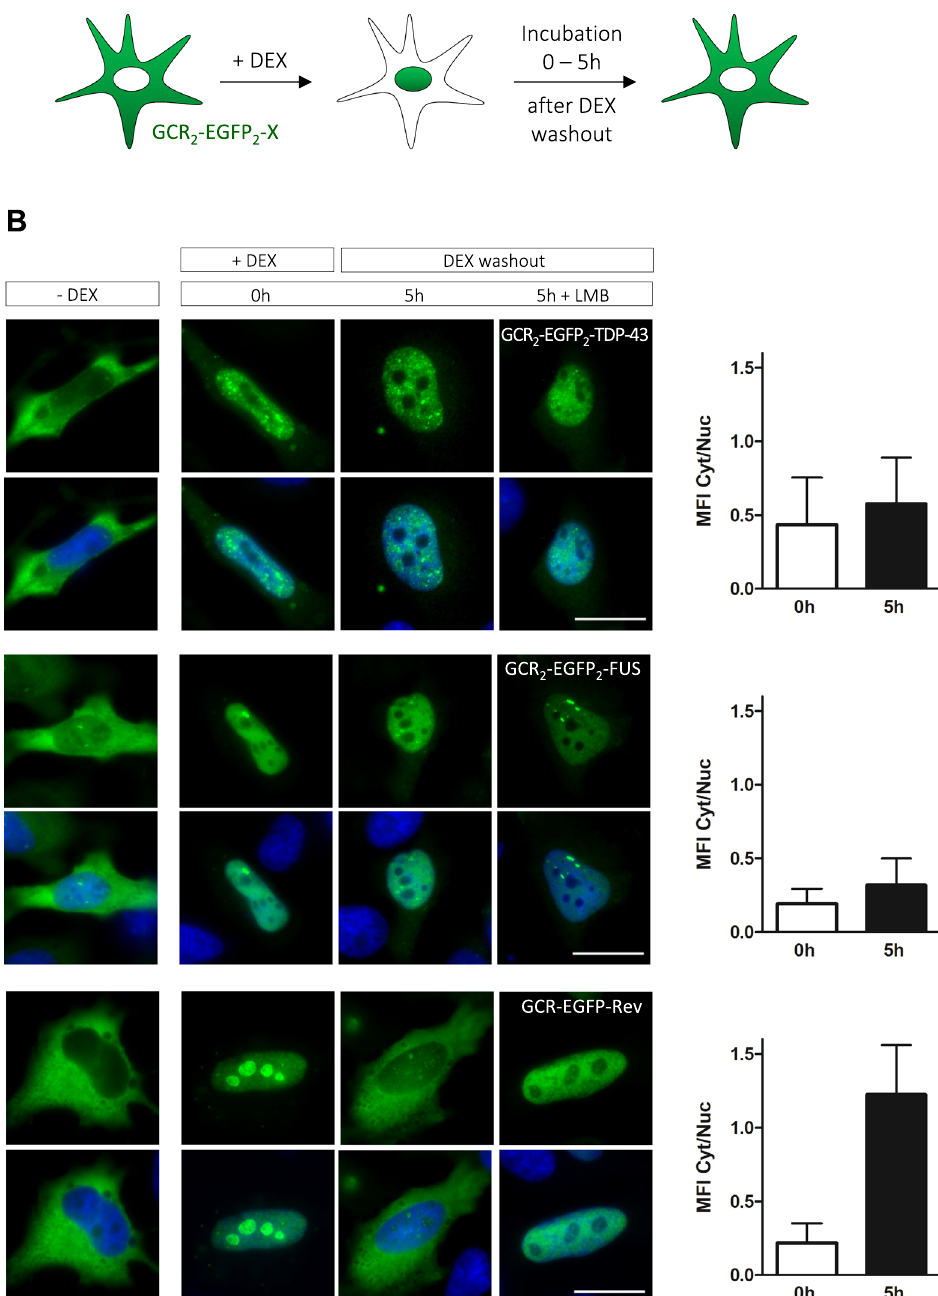
Figure 4. TDP-43 and FUS enlarged by ~120 kDa are poorly exported, suggesting that TDP-43 and FUS leave the nucleus by passive diffusion. ( A ) Schematic diagram of the hormone-induced nuclear transport assay. An NLS-containing protein-of-interest (X) is attached to the hormone-responsive domain of the glucocorticoid receptor (GCR). The GCR domains trap the fusion protein in the cytoplasm until dexamethasone addition ( + DEX) releases trapping and induces rapid nuclear import. If the protein-of-interest contains an NES that mediates active nuclear export, rapid relocalization to the cytoplasm is observed after dexamethasone washout. ( B ) GCR 2 -EGFP 2 (119 kDa) fused to TDP-43 or FUS were transiently expressed in HeLa cells and nuclear import was induced by DEX addition ( + DEX). Localization of fusion proteins was examined at the indicated timepoints after DEX washout in the absence or presence of leptomycin B (LMB). Even 5 h after DEX removal, GCR 2 -EGFP 2 -TDP-43 or -FUS remain predominantly nuclear and only small amounts are observed in the cytoplasm. In contrast, GCR-EGFP-Rev (73 kDa), which contains a functional CRM1-dependent NES, is efficiently exported after DEX washout and its export is blocked by LMB treatment, demonstrating CRM1 dependence. Scale bars: 20 μ m. Bar graphs to the right show MFI Cyt/Nuc ratios for the 0 h and 5 h timepoints (40 cells/condition from one representative experiment out of three), error bars indicate